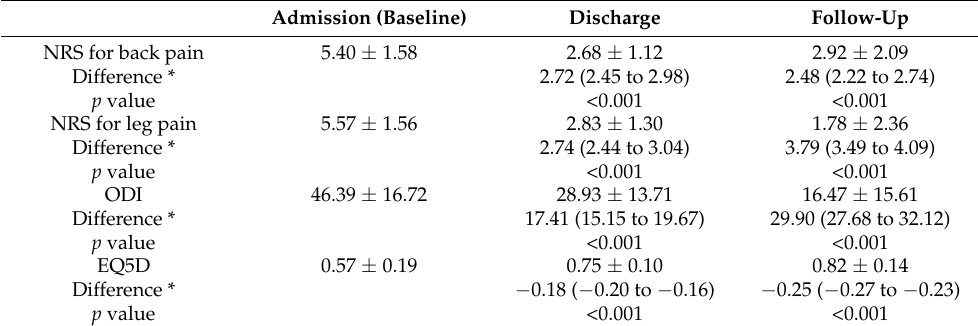
Table 3. Change in outcome at discharge and follow-up of participants.